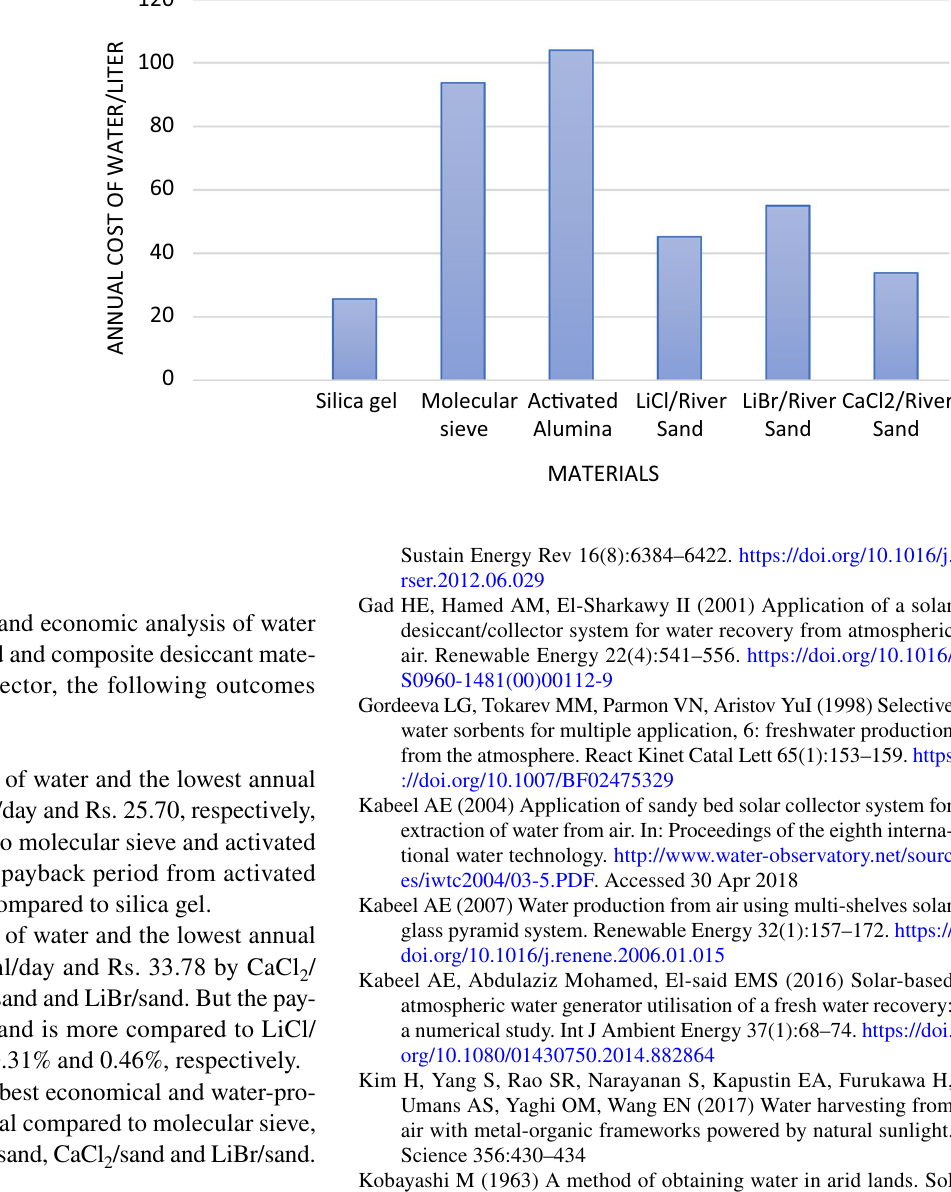
Fig. 9 Annual cost of water per liter by different